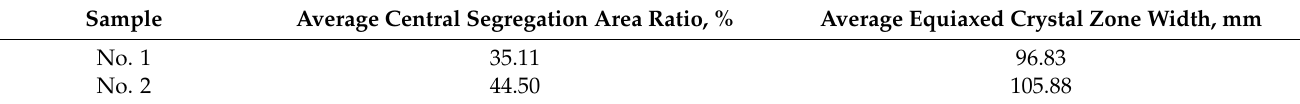
Table 3. Average central segregation area ratio and equiaxed crystal zone width of billet No. 1 and No. 2.